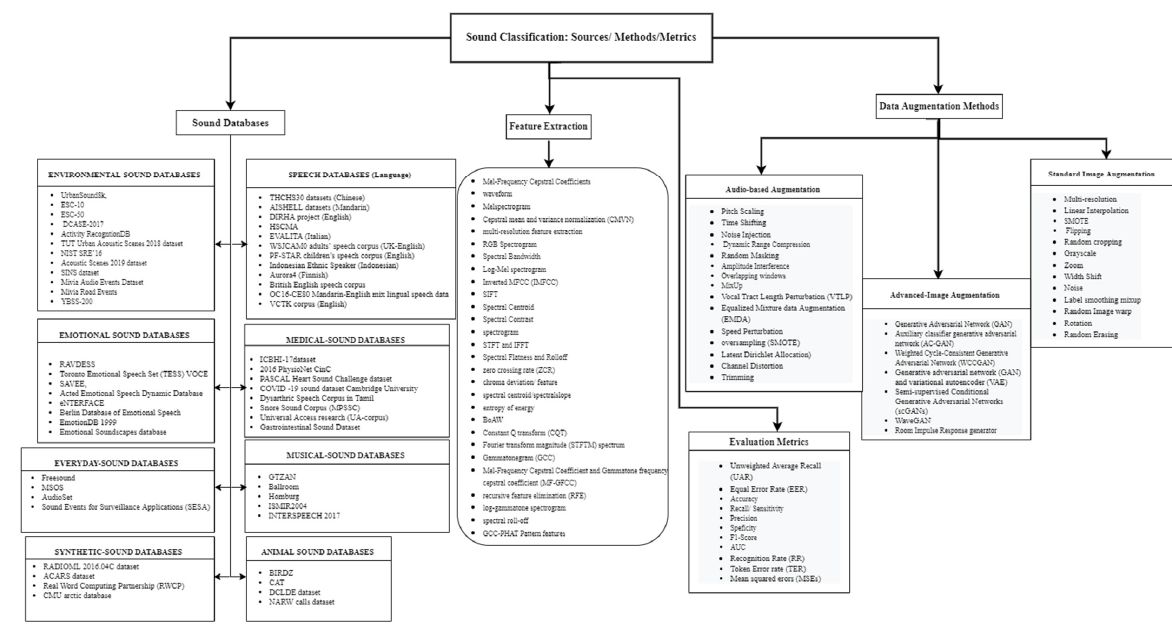
Figure 15. Taxonomy of methods using in sound classification.